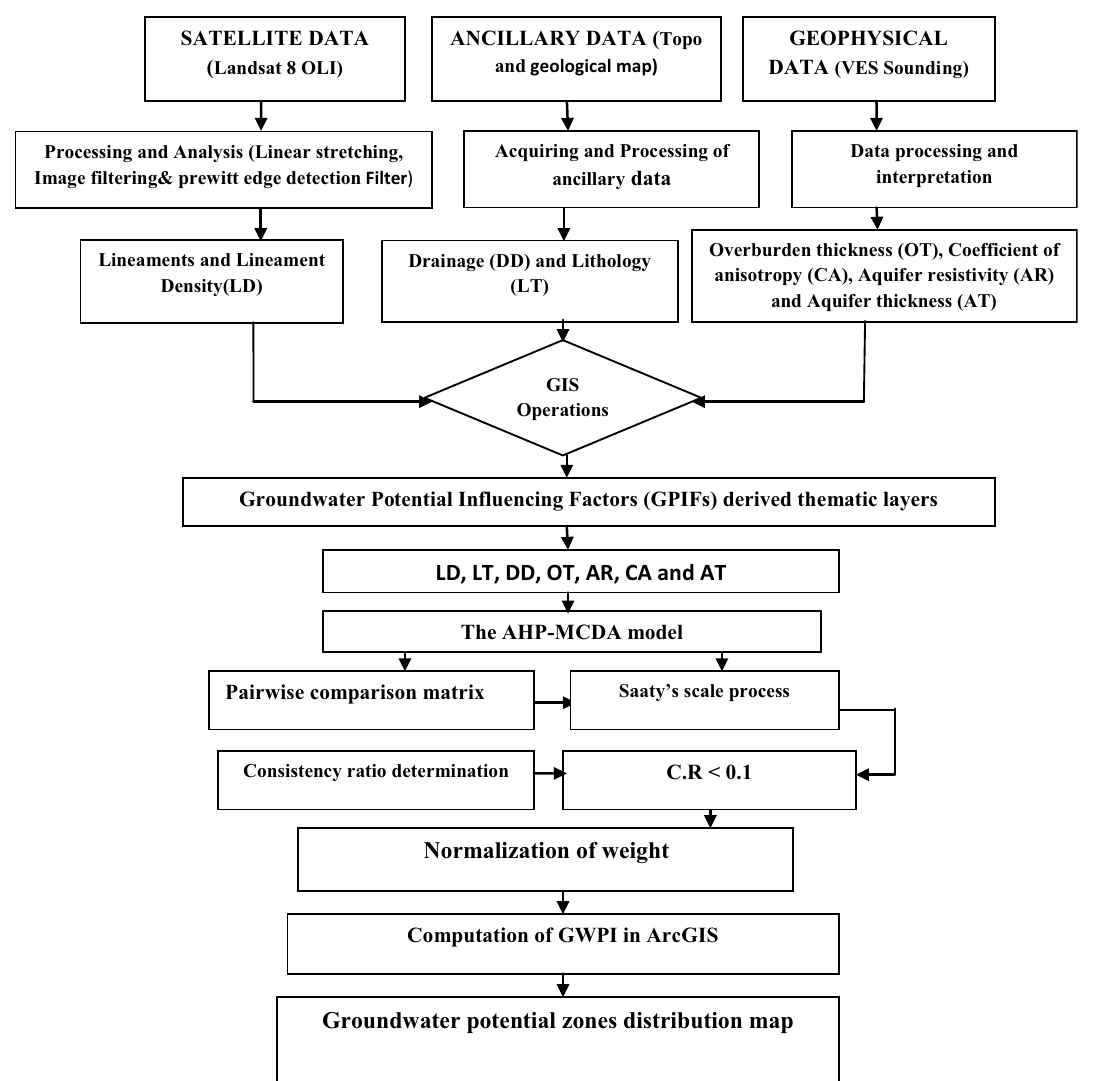
Fig. 4 Simplified flow diagram showing various steps adopted to generate groundwater potential distribution map of the study